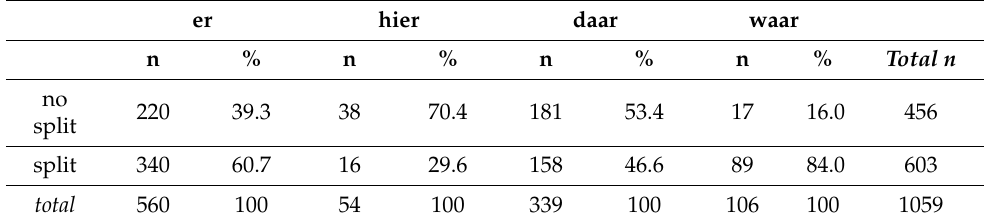
Table 7. The number of split and unsplit PPs per (realized) R-pronoun. er